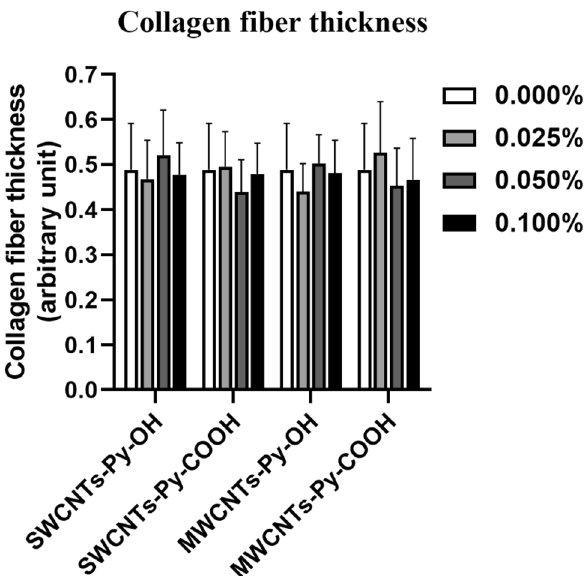
Figure 14. SEM evaluation of collagen-based ECT constructs of 3T3 cells with different loaded CNTs. Collagen fiber thickness was digitally quantified by ImageJ. The data were analyzed by a one-way ANOVA test, n = 12.